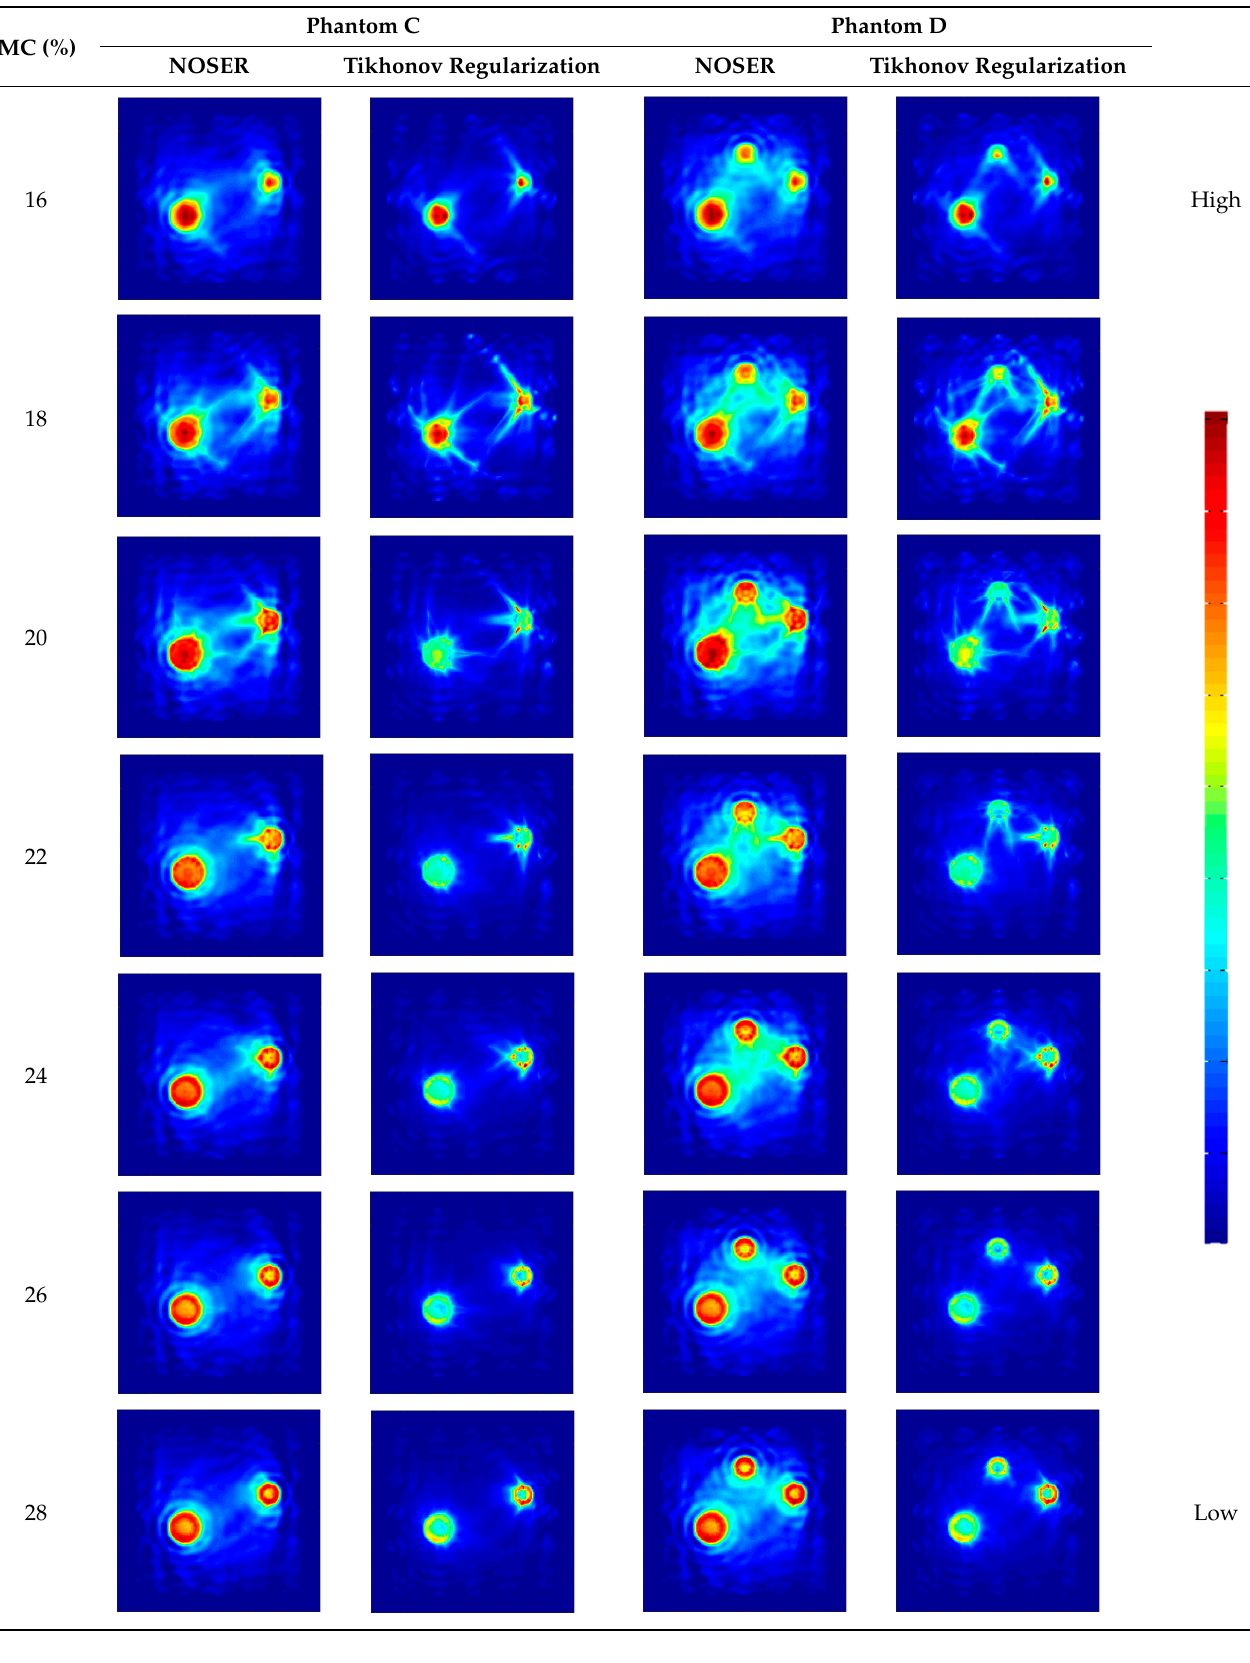
Table 3. Reconstructed images for Phantoms C and D at different percentages of MC.